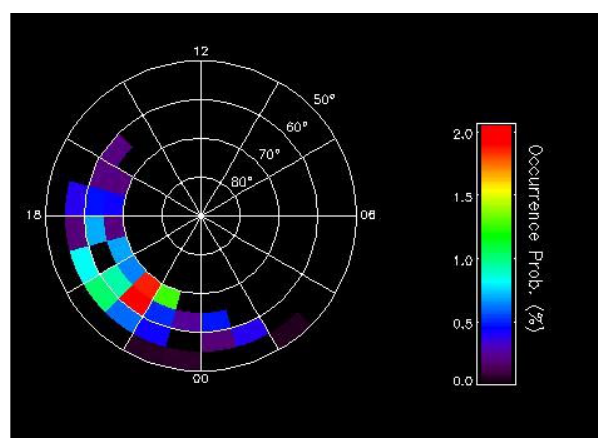
Fig. 1. Occurrence probability of observed subauroral ion drift